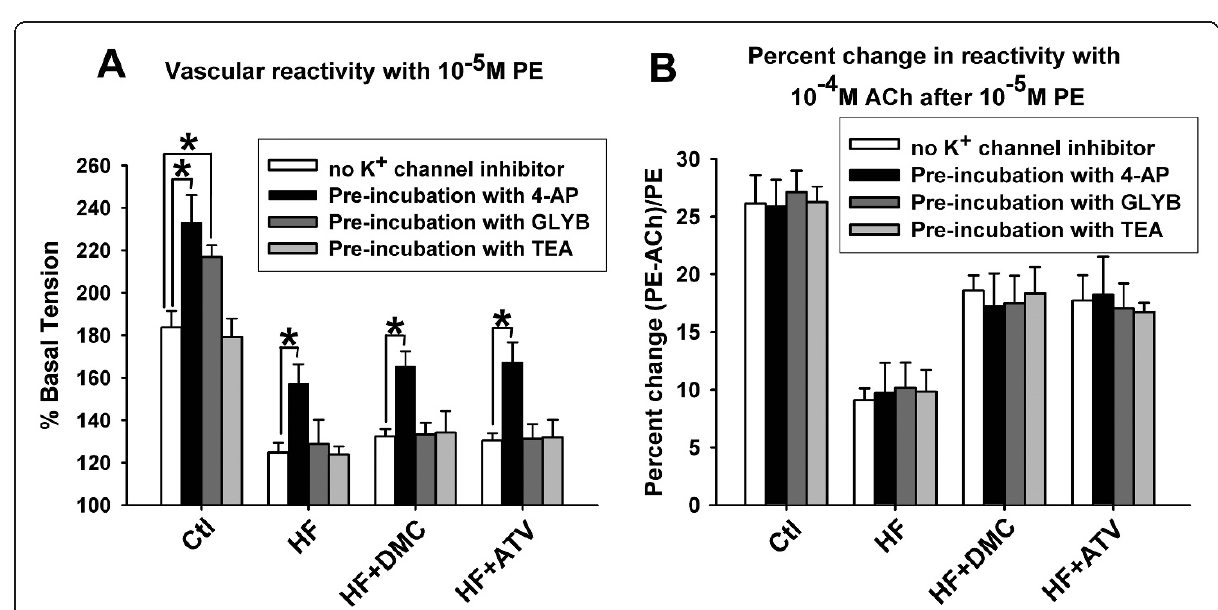
Figure 2 Effect of K+ channels on the contraction of aortic rings . ( A ) The contraction of aortic rings with 10 -5 M PE before and after pre- incubation with 4-AP, 3 mM, K V channel blocker; TEA 1 mM, BK Ca channel blocker and GLYB, 1 μ M, K ATP channel blocker respectively for 30 min. ( B ) The percent change in relaxation ((tension PE - tension Ach)/tension PE) to 10 -4 M ACh after 10 -5 M PE before and after pre-incubation with three K + channel blockers respectively. Data presented as mean ± S.E.M. and expressed as percentage of baseline tension. * P < 0.01 vs. contraction value of corresponding group before pre-incubation of K + channel blocker, n = 8-10 rings from 5-6 rats.